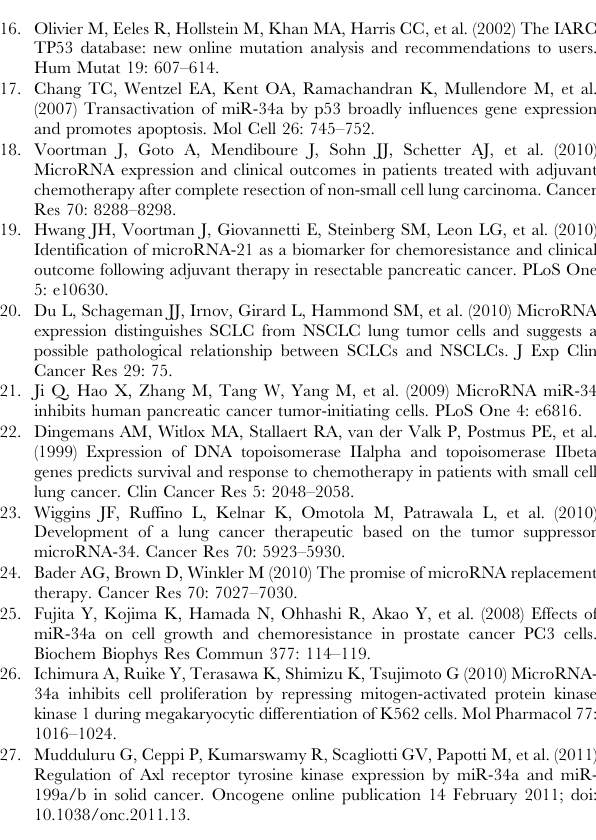
transfected with the indicated oligonucleotides. Error bars indicate standard deviation of assays in triplicate. (TIF) Figure S7 Protein expression of c-MET and bcl-2 in 5 SCLC and 3 NSCLC cell lines. (B) Correlation between miR-34a and c-MET expression as well as bcl-2 in 5 SCLC cell lines. Table S1 MicroRNAs and clinical covariables. Table S2 Effect of clinical covariables on progression- free survival (PFS). Table S3 Effect of microRNA expression on progres- sion-free survival (PFS, weeks) in SCLC patients strat- ified by limited disease or extensive disease. Table S4 TP53 status and miR-34a expression in SCLC cell lines. (DOC) Materials S1 Cancer cell